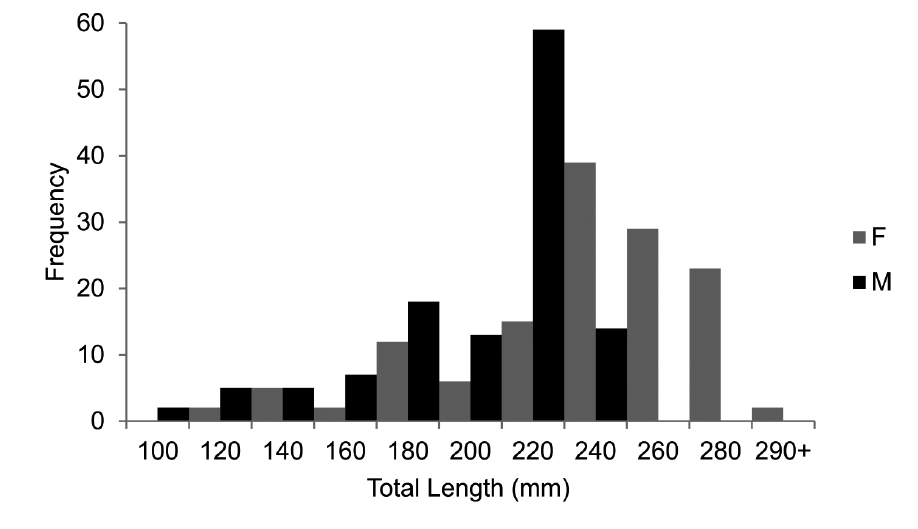
FIGURE 2 | Size classes frequency distribution of Urotrygon microphthalmum . Values in horizontal axis are the centre of size classes. F = females; M =